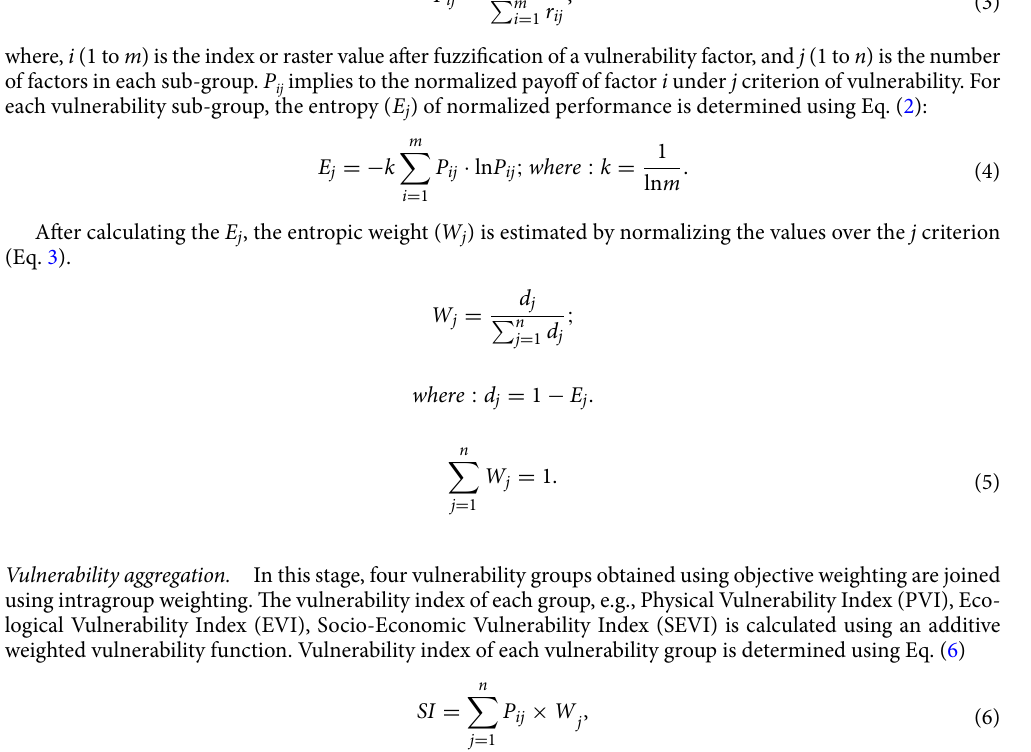
highest recorded height of a surge in SC coast is about 8 m; thus, the area with elevation above 8 m are assigned as low vulnerable areas, as they are less susceptible to coastal flooding caused by storm surges (Table 3). The region’s soil type and land cover maps are obtained from gSSURGO soil maps to classify the hydrologic soil groups (Table 2). The impact of landuse on coastal vulnerability is represented by SCS curve numbers determined based on USDA guidelines (USDA 1999) and classified using Jenks optimization based natural breaks methods into vulnerability classes. A Euclidean distance map is generated to classify the area into five vulnerability zones based on distance.